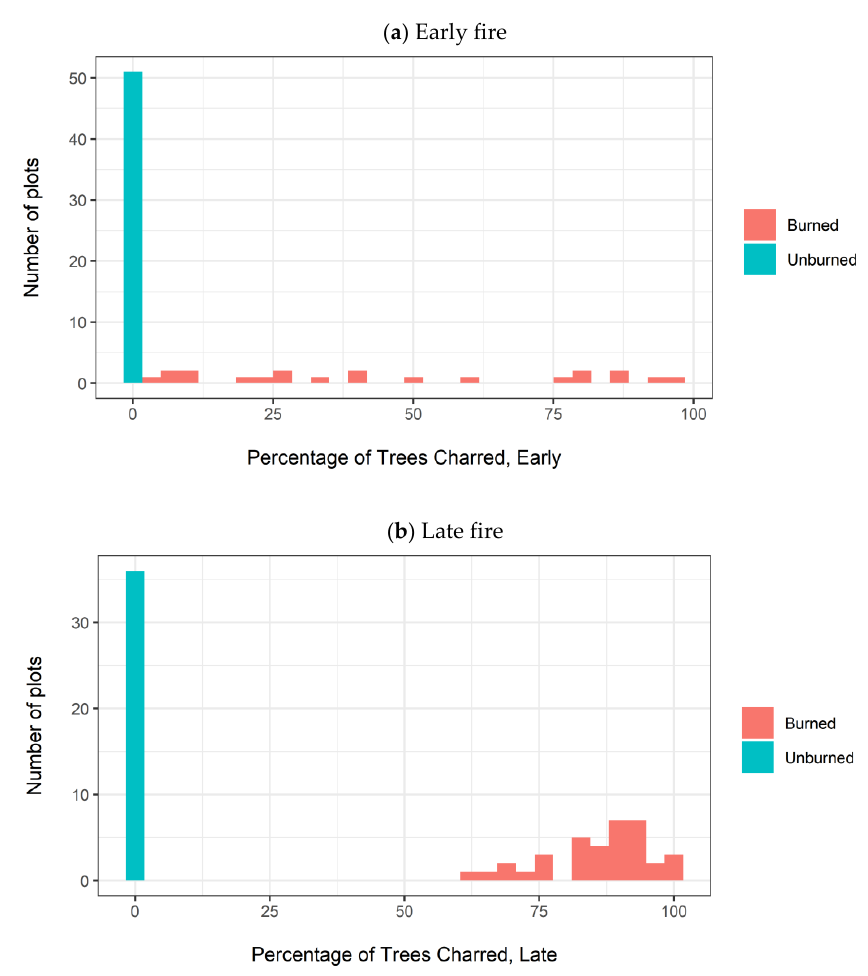
Figure A4. Histograms of percentage of live overstory trees within a plot showing charring after ( a ) Early fire (spring 2004 prescribed fires) and ( b ) Late fire (spring 2006 prescribed fires or fall 2012 wildfire). Char data were recorded in summer 2004 (Early fire) and summer 2015 (Late fire). Plots are color-coded by burn status (burned/unburned). These binary designations were used for ‘Early fire’ and ‘Late fire’ explanatory variables in applicable models (see Table 2, main text).